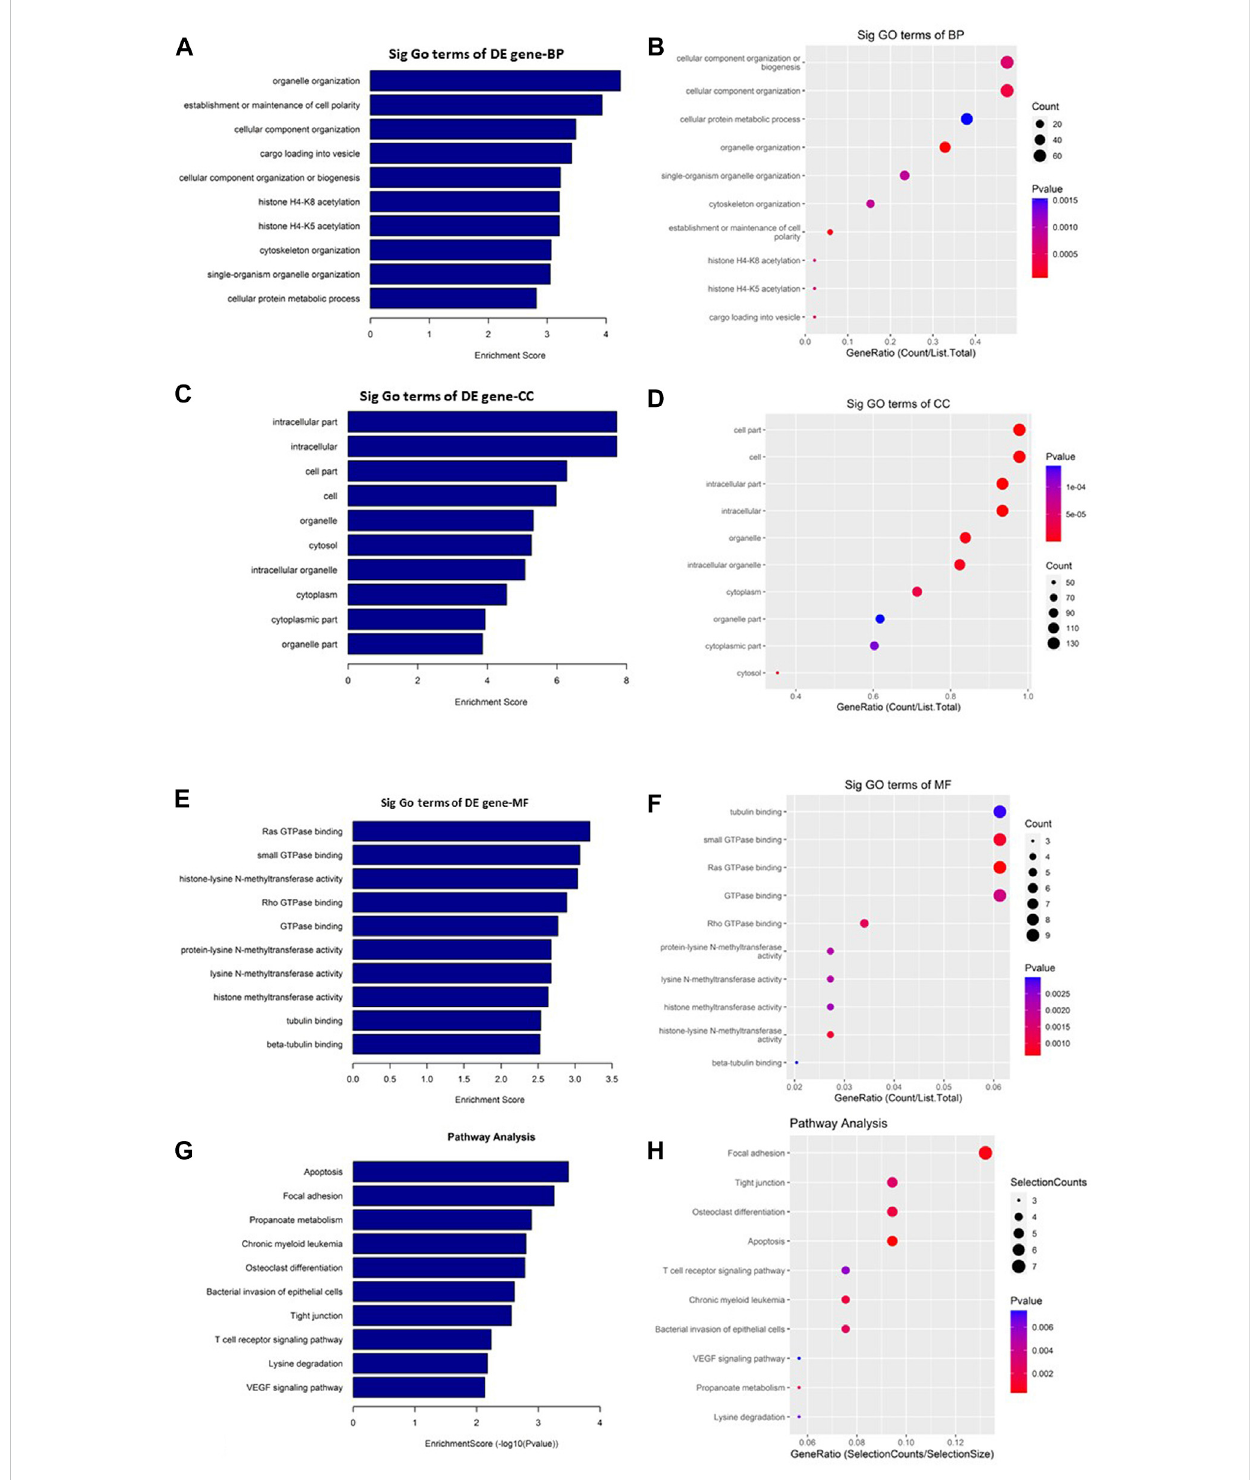
FIGURE 5 Gene Ontology (GO) and Kyoto Encyclopedia of Genes and Genomes (KEGG) pathway analyses of upregulated circRNAs in the GO-AgNPs treated caprine fetal fi broblast cells (CFFCs). GO analysis identi fi ed biological process (BP), cellular compo-nent (CC) and molecular function (MF) with the enrichment score [ (A,C,E) respectively] and gene count (B,D,F) . The top ten enriched KEGG pathways of signi fi cantly altered circRNA genes (G,H) . The color intensity of the nodes shows the degree of enrichment of this analysis. The enrich-factor is de fi ned as the ratio of the differential genes in the entire genome. The dot size represents the count of genes in a